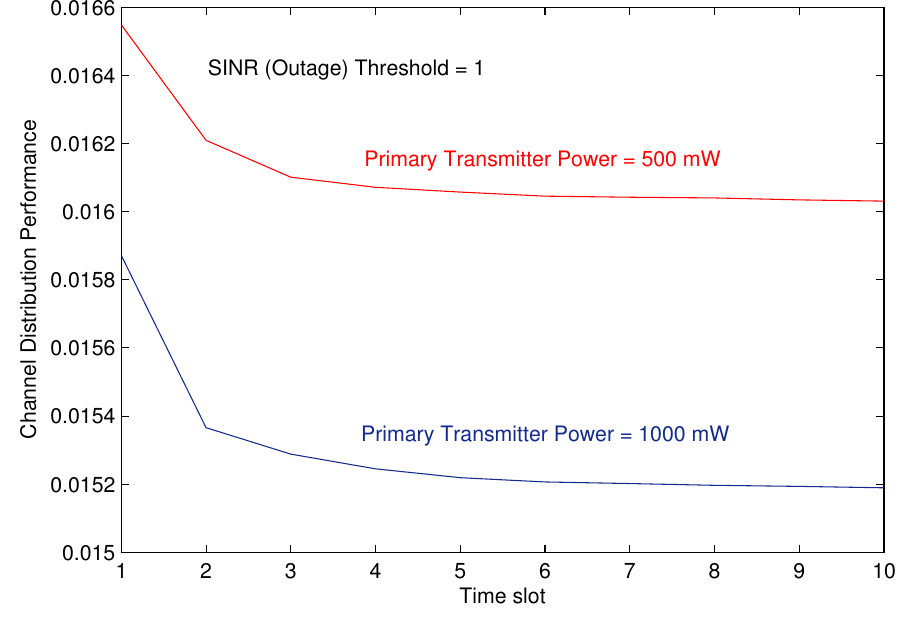
Figure 12. ChDistFairness against time slots for PT transmission power levels of 500 and 1000 mW. Experiment 10. In the last experiment, ChDistFairness results are compared for greedy, proposed maximum independent set (MIS)-based, and proposed metric based allocation mechanisms against time slots under the same average percentage of STs in HZ. Parameters used in this experiment can be summarized as